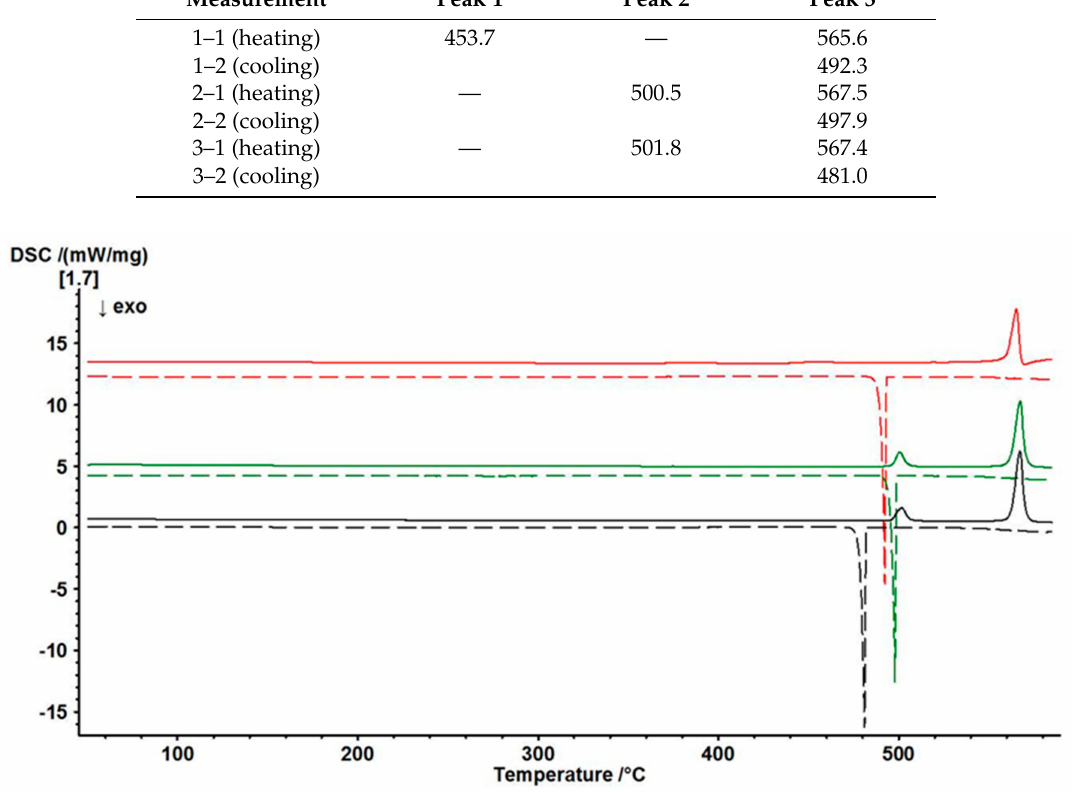
Figure 9. DSC measurements with multiple heating/cooling cycles of an identical γ -PbTeO 3 sample, starting from γ -PbTeO 3 (temperature range 25–590 ◦ C). Heatings are shown with closed lines, coolings with dashed lines. First cycle (red), second cycle (green), third cycle